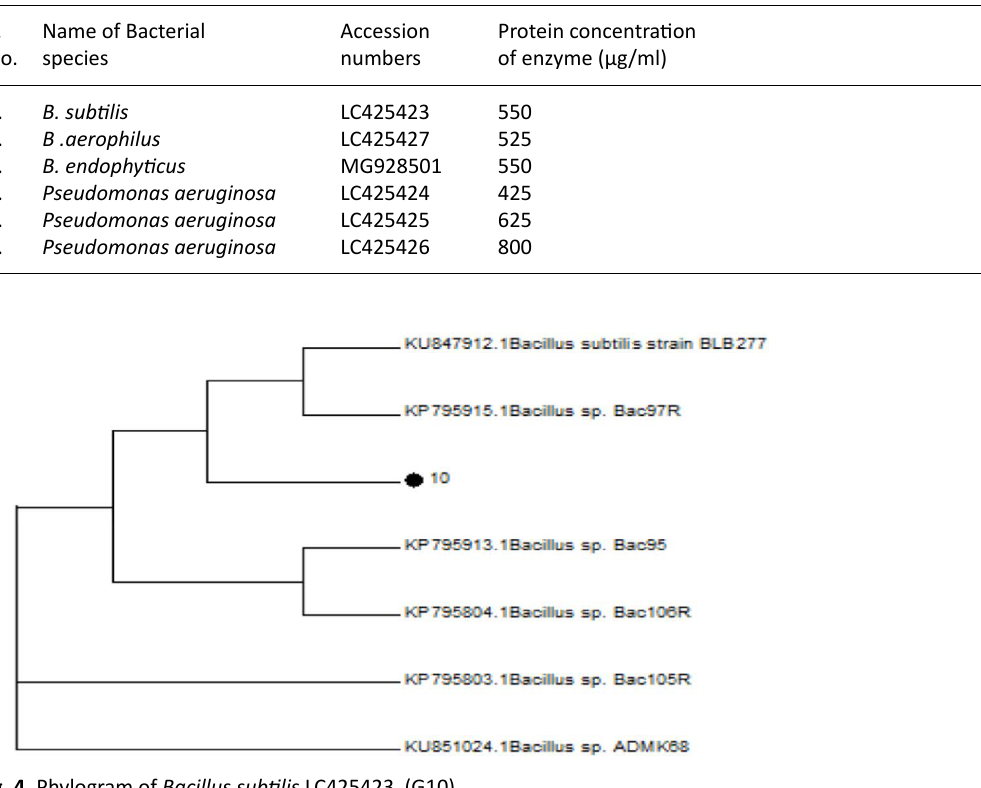
Fig. 4. Phylogram of Bacillus subtilis LC425423 (G10)